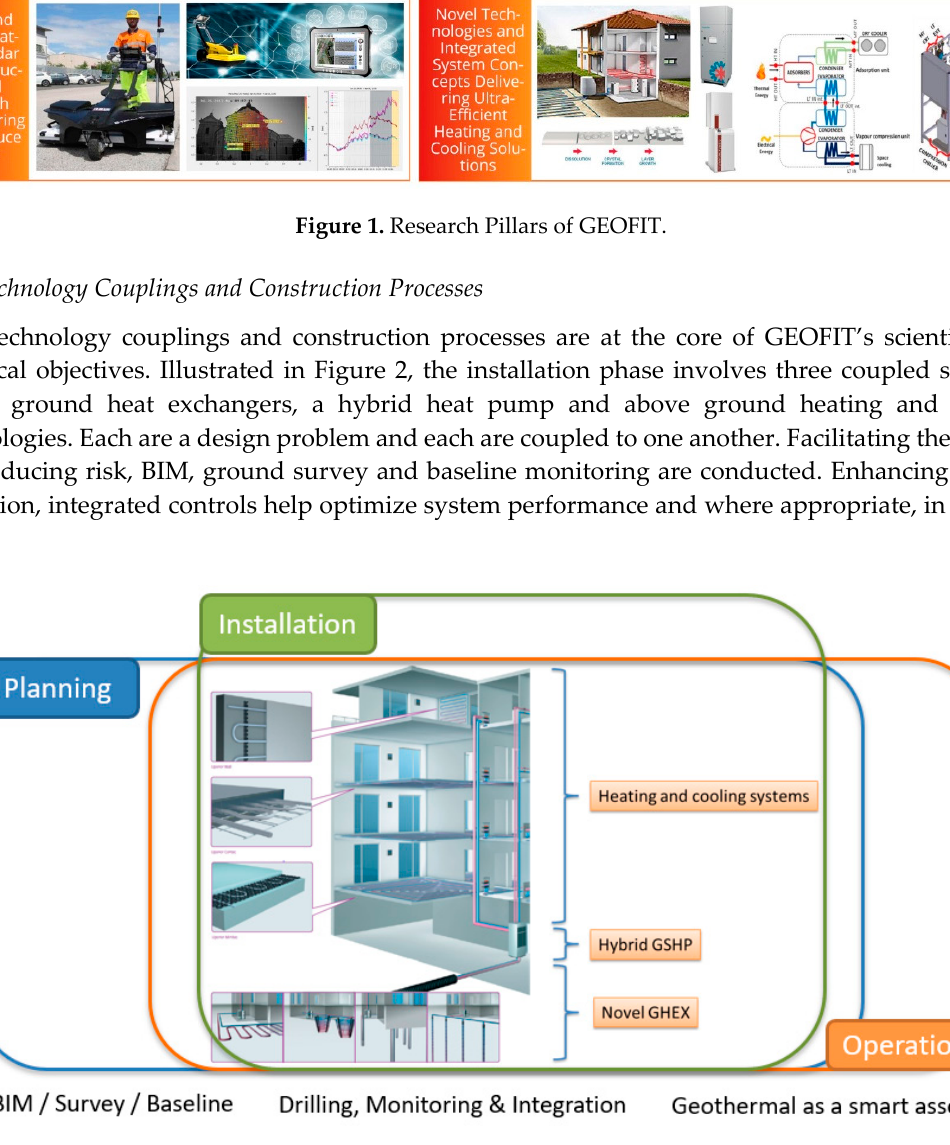
Figure 2. Technologies, Couplings & Construction